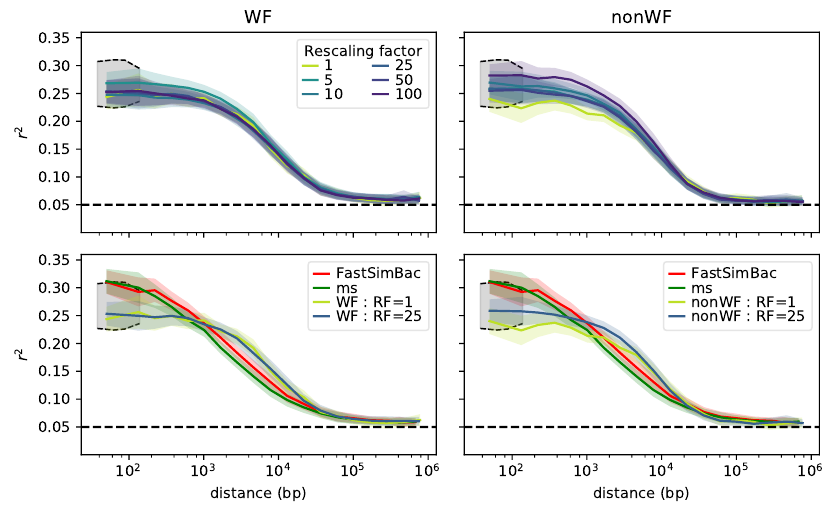
Figure 3 – Linkage disequilibrium for WF (left) and nonWF (right) simulations under dif- ferent rescaling factors (RFs) and for ms and FastSimBac (bottom). The horizontal dashed 2 line indicates the expected r with free recombination when sampling 20 individuals (1/20). The colored shaded areas represent standard error of the mean, and the gray area toward the left of each panel represents the range of expected values at very short 10 − 9 ; Ne = 140k; distances. Parameters used: chromosome size = 2Mb; µ = ρ = 1 . 53 × 20000 generations. Rescaling does not affect the shape of LD (top), which matches that of coalescent simulators fairly well